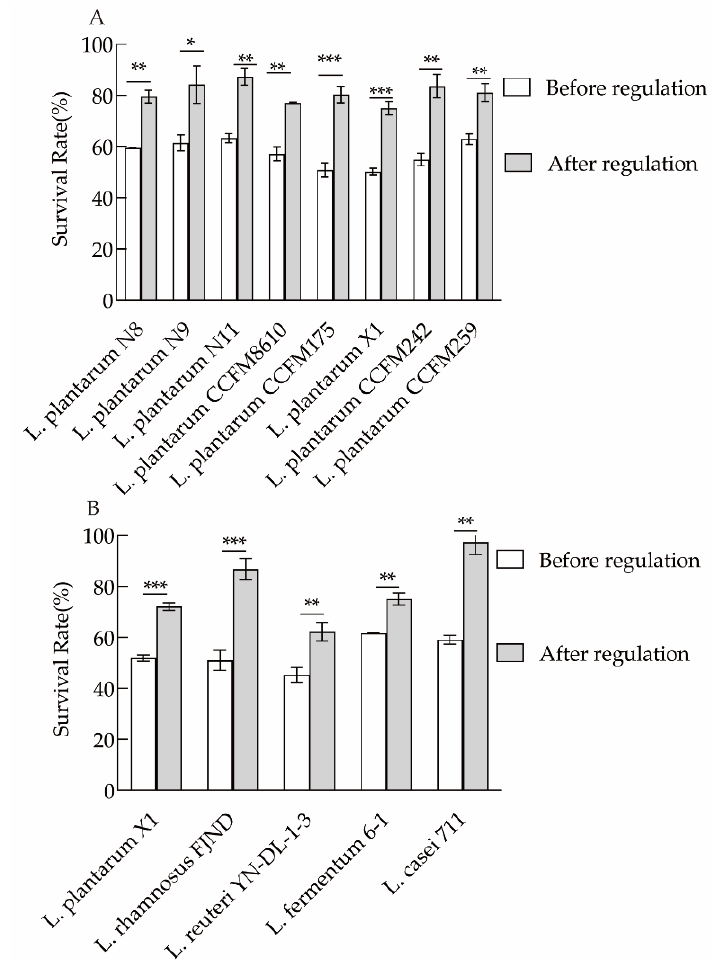
Figure 6. Changes in the survival rate of L. plantarum ( A ) and other lactobacilli species ( B ) after cell membrane regulation. Significant differences are indicated using * ( p < 0.05), ** ( p < 0.01) and *** ( p < 0.001).